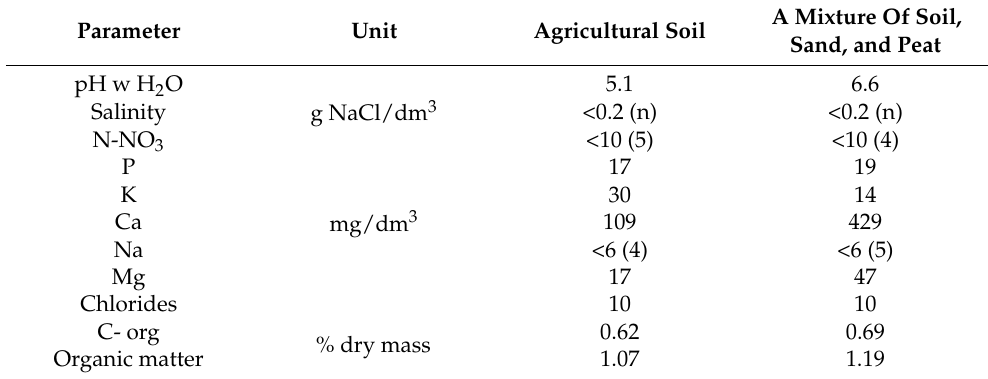
Table 1. Properties of the soil used in the